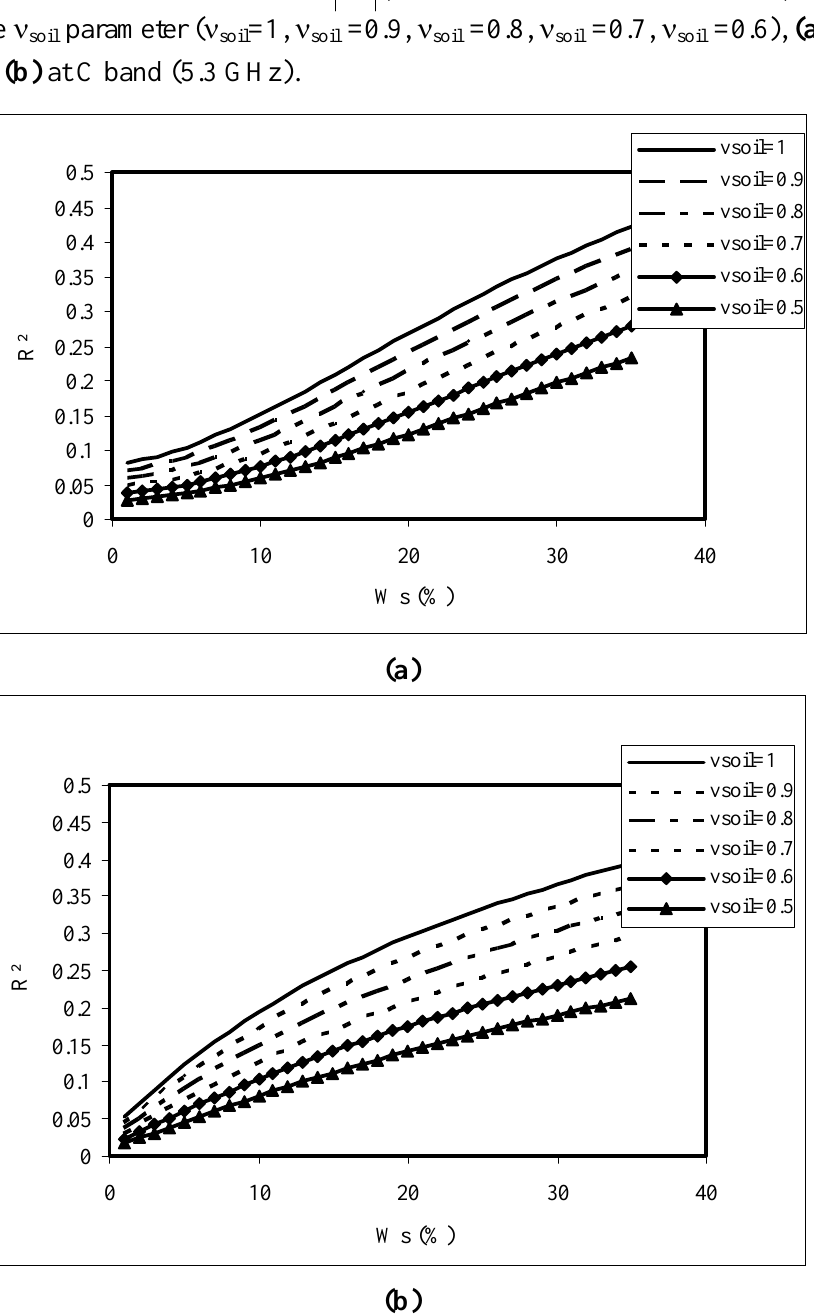
parameter (  =1,  =0.9,  =0.8,  =0.7,  =0.6), (a) at L band soil soil soil soil soil soil